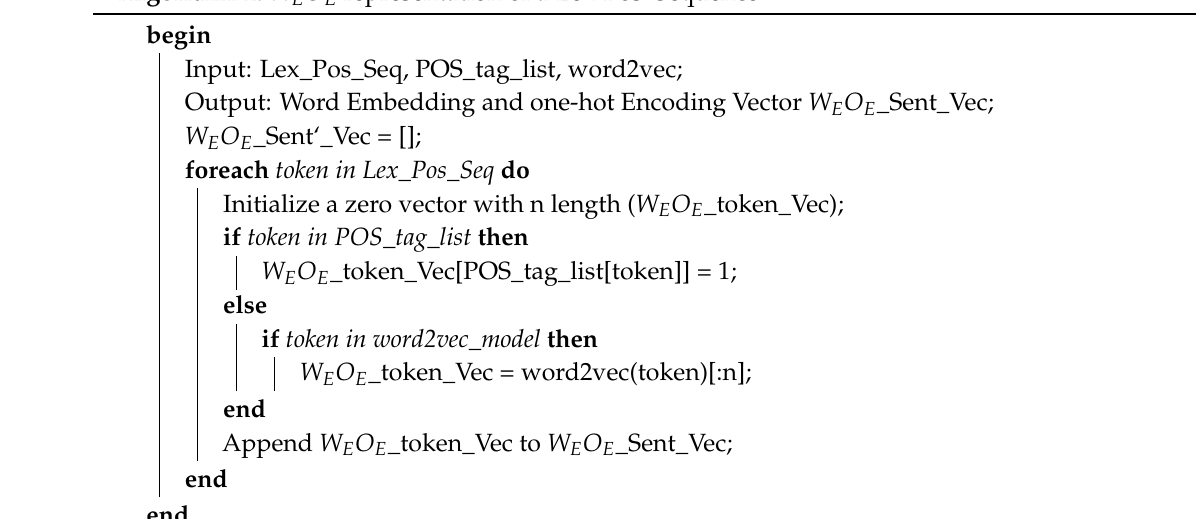
Algorithm 2: W E O E representation of a Lex-Pos